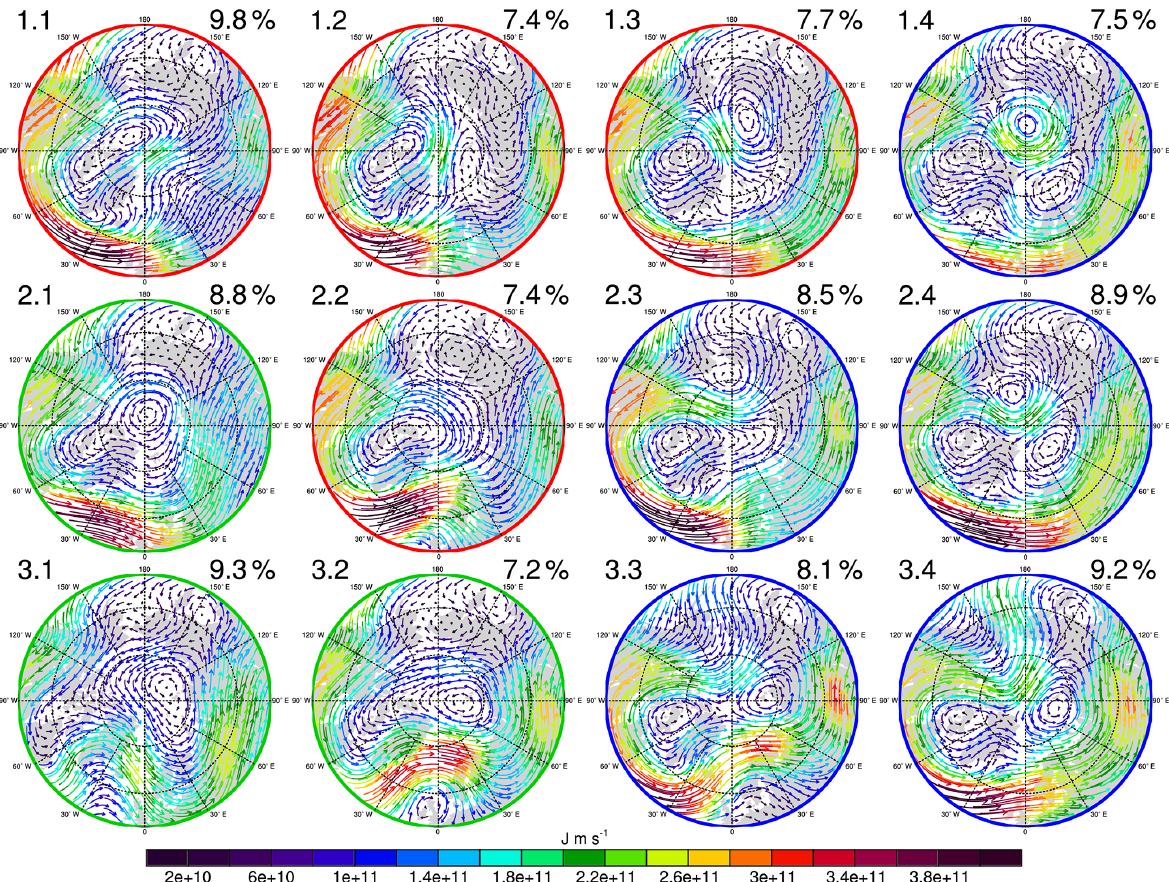
Figure 1. SOM with 4 columns and 3 rows of vertically integrated (200–1000hPa) horizontal MSE transport (MSET) from winter ERA- Interim data (1979–2016). Numbers on the top left of each SOM are used to name different patterns, percentages in the top right of each pattern correspond to the relative frequency of occurrence during the analysed time period. The maps are centred at 0 ◦ E. The vectors show the vertically integrated horizontal MSET. Red vectors correspond to large magnitudes of MSET, while blue vectors correspond to small magnitudes of MSET. Differently coloured frames indicate patterns that were grouped together.